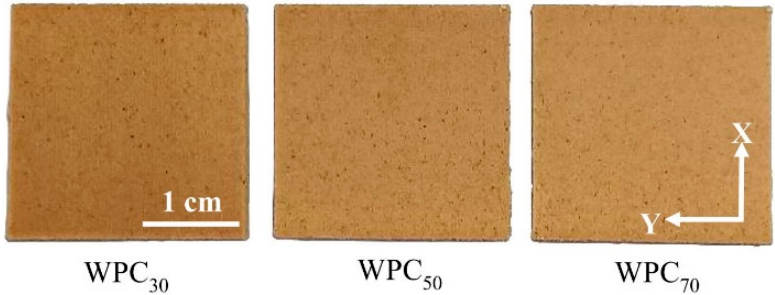
Figure 6. Surface appearances of FDM-printed WPC parts at various printing speeds. Table 1. Surface color parameters of FDM-printed WPC parts at various printing speeds. Code